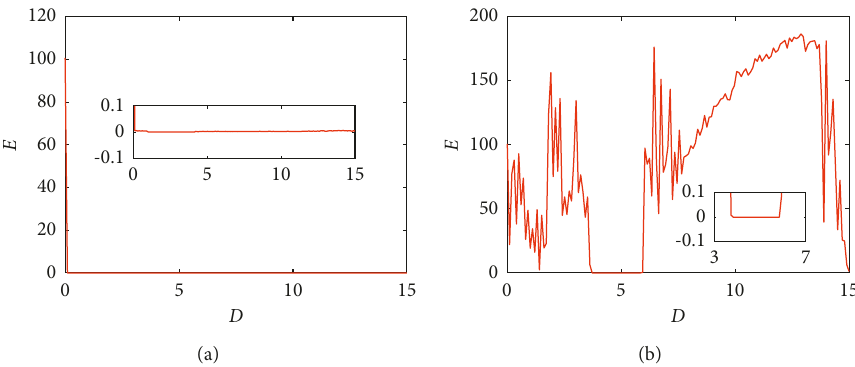
Figure 7: The synchronization errors of the coupled model with respect to coupling strength at case 1 (spiking and quiescent neurons). For (a) τ � 0 . 5; (b) τ � 3. Partially enlarged interval for partial synchronization, and the initial values are selected with (0.1, 0.01, 1.05, 0.1, 0.01,